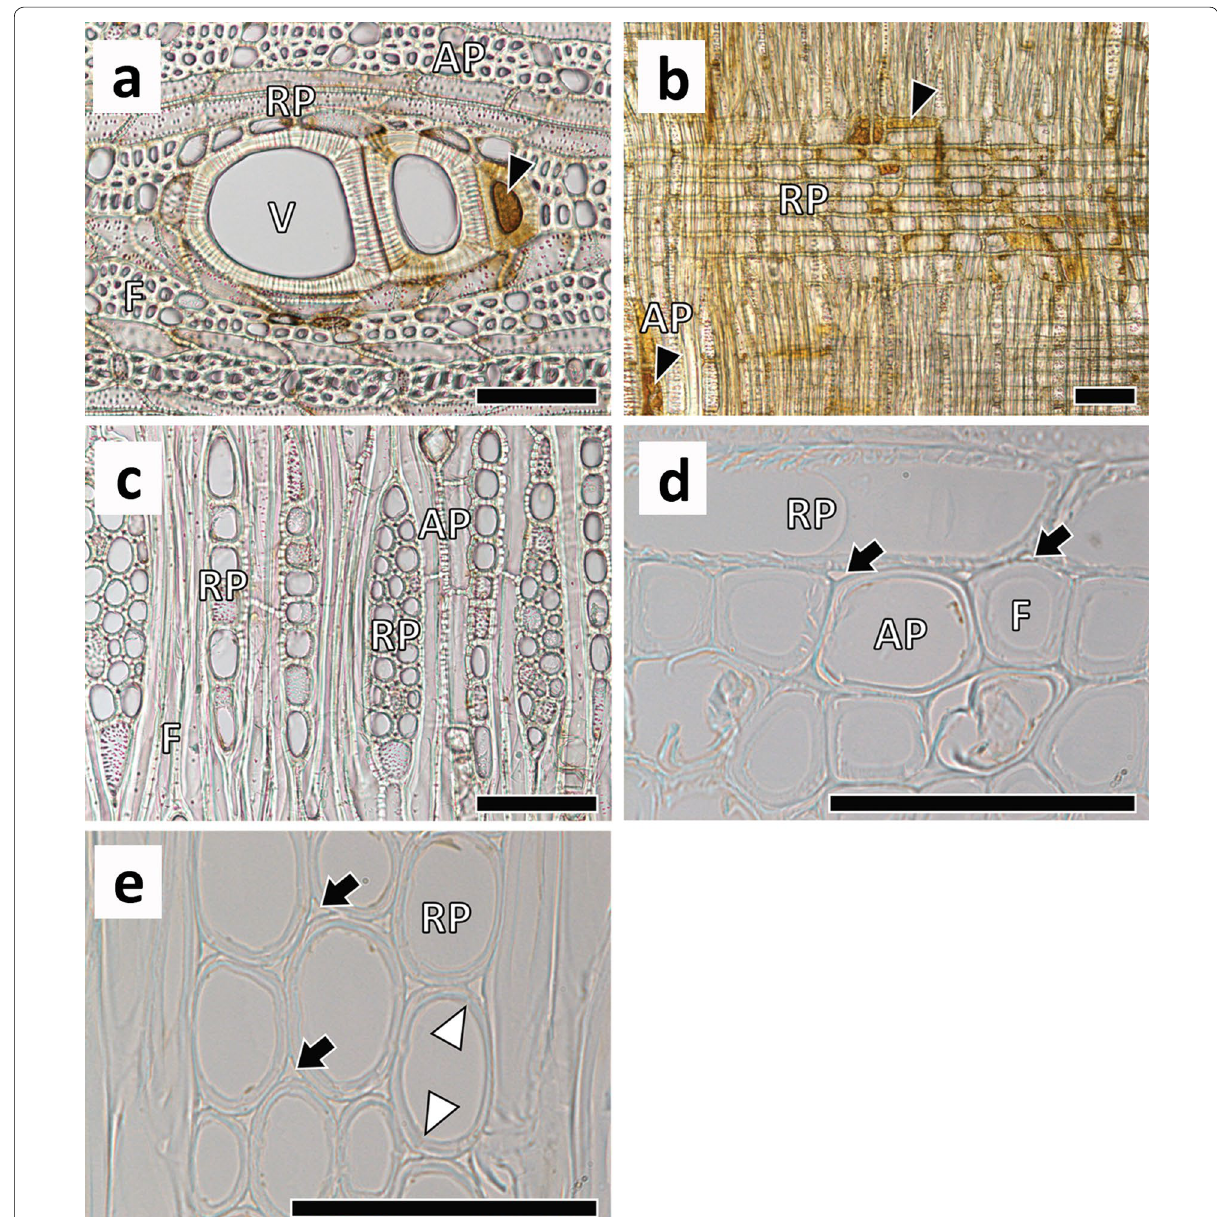
Fig. 2 Light micrographs of transverse ( a , d ), radial ( b ) and tangential ( c , e ) sections of whitish regions of samples of D . kaki wood. Black arrowheads indicate colored substances. Black arrows indicate intercellular spaces in the rays where no colored substances were found. White arrowheads indicate blind pits in ray parenchyma cells. AP: axial parenchyma cell; F: wood fiber; RP: ray parenchyma cell; V: vessel element. Scale bars in a – c ; 50 μm in d and